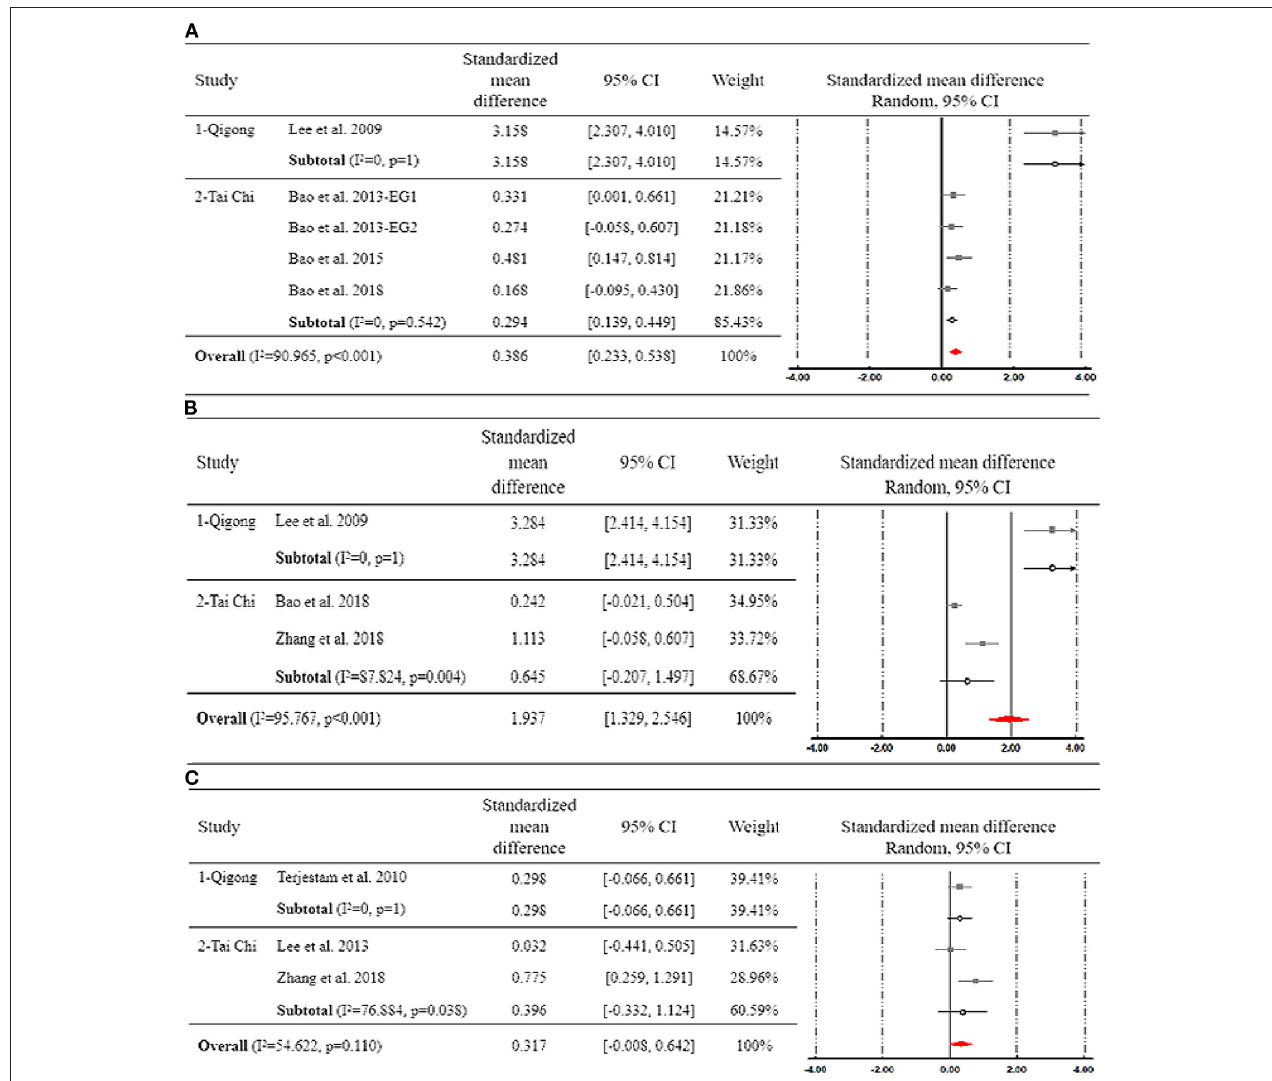
FIGURE 2 | Forest plot for subgroup analysis regarding the effect of Tai Chi and Qigong on (A) anxiety, (B) depression, and (C) stress.